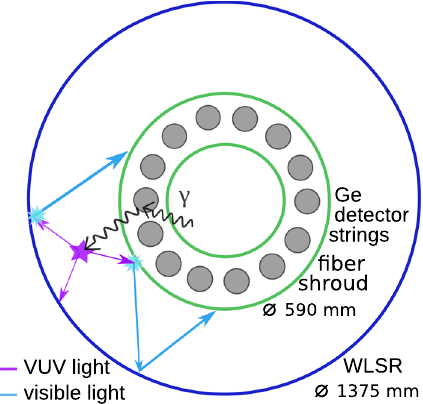
Fig. 2 In LEGEND-200, the germanium crystals will be immersed in LAr and surrounded by wavelength-shifting fibers. The fibers are coated with TPB, which absorbs the VUV light created by an event in LArandre-emitsitinaspectralregionthatmatchestheabsorptionofthe fibers (shown in Fig.1). The fibers re-emit this light in the green region, which is then detected by silicon photomultipliers. Wavelength-shifting reflectors (WLSR) surround the fibers, shifting the VUV scintillation light and reflecting visible light towards the fibers